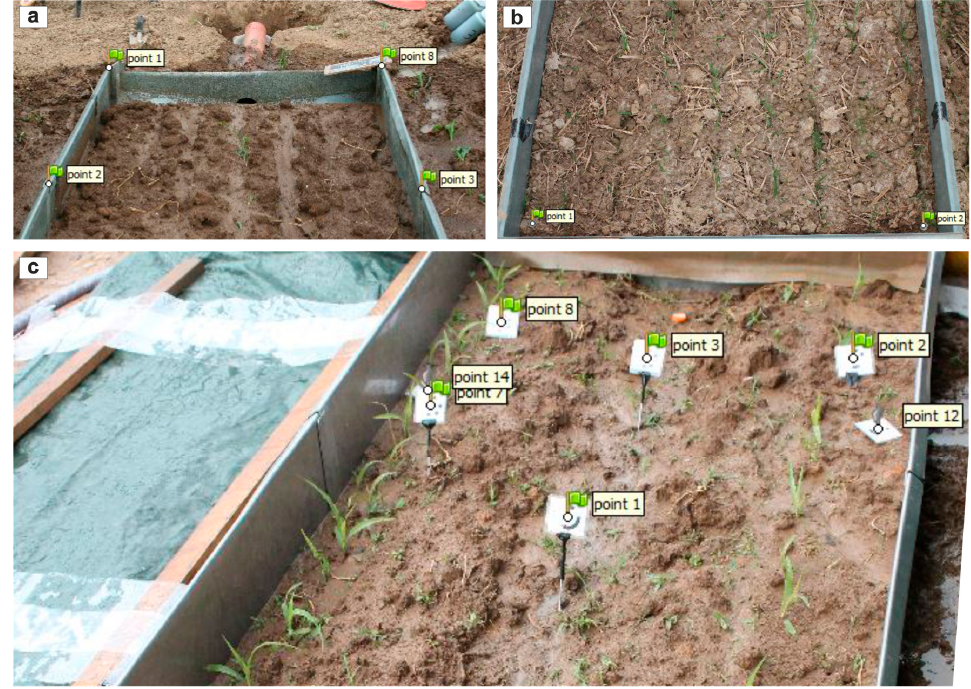
Figure 4. The marker points on the metal sheets of one of the experimental Nossen I-plots ( a ), on the soil surface for Nossen II ( b ) and Nossen III ( c